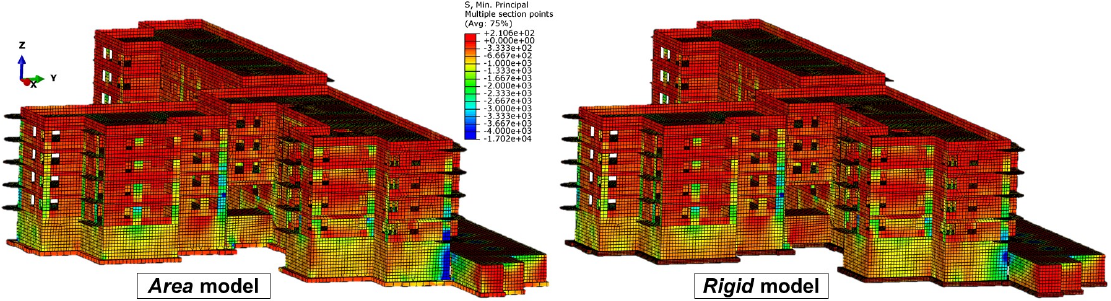
Figure 21. Comparison of the minimum principal stress maps [kPa] of the building in the AREA and RIGID models.